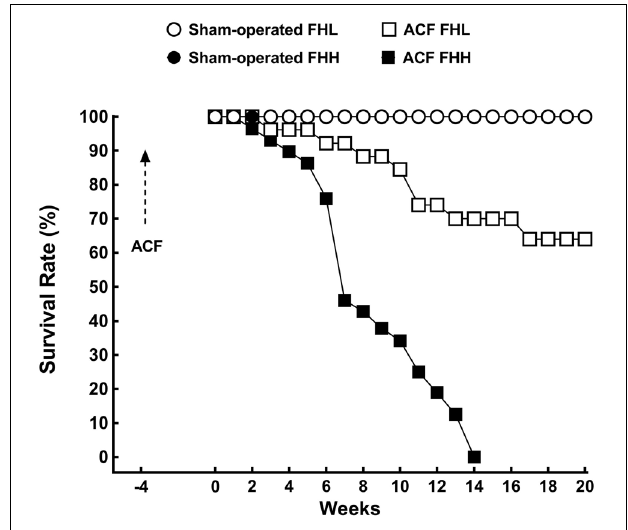
FIGURE 1 | Survival rates in sham-operated fawn-hooded low-pressure (FHL), sham-operated hypertensive (FHH) rats and in untreated FHL, and FHH rats with aorto-caval fistula (ACF). The survival profiles (straight line) for sham-operated FHL and FHH were superimposable and are depicted by one symbol only (blank circles).The survival rate of ACF FHL was significantly lower than in sham-operated FHL rats and in ACF FHH it was the lowest of all experimental groups (analyzed by log-rank Mantel-Cox test followed by Gehan-Breslow-Wilcoxon